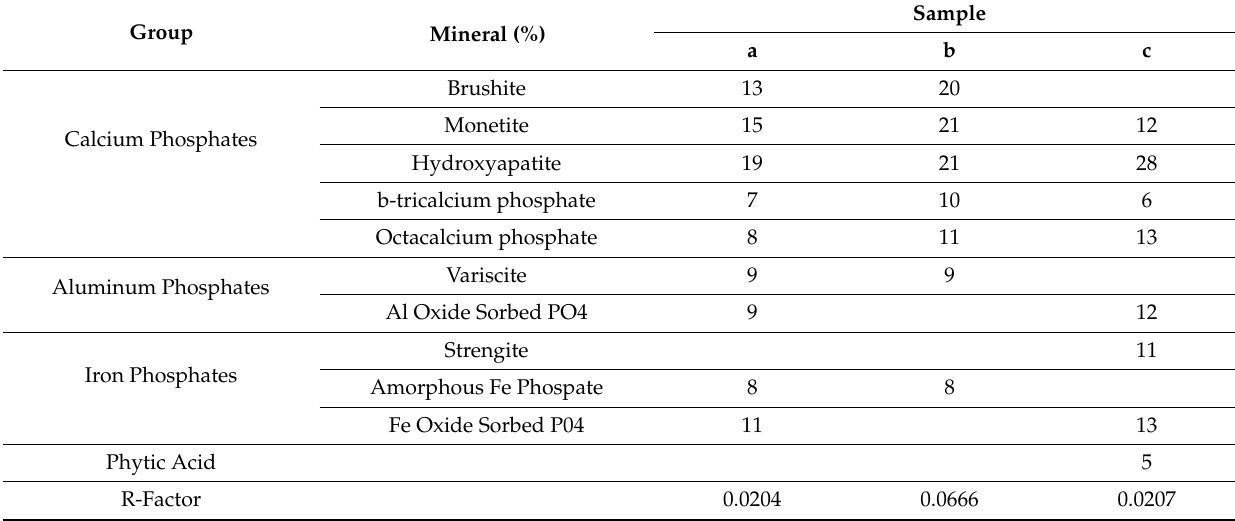
Table 8. XANES analysis of three initial samples taken at construction in SR cells; (a) 0 to 150 mm, (b,c) 300 to 450 mm separated by 2 m